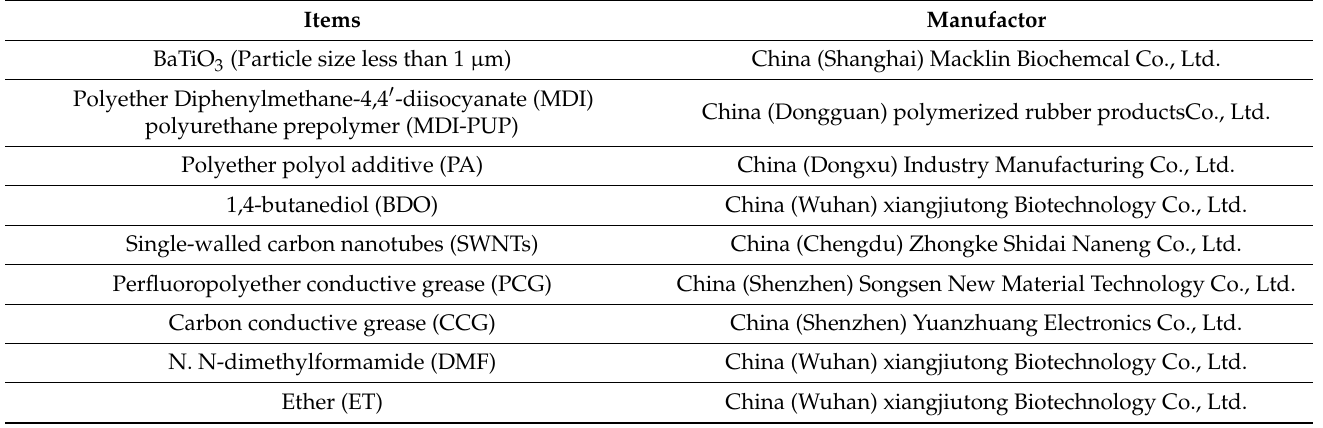
Table 1. The main raw materials.